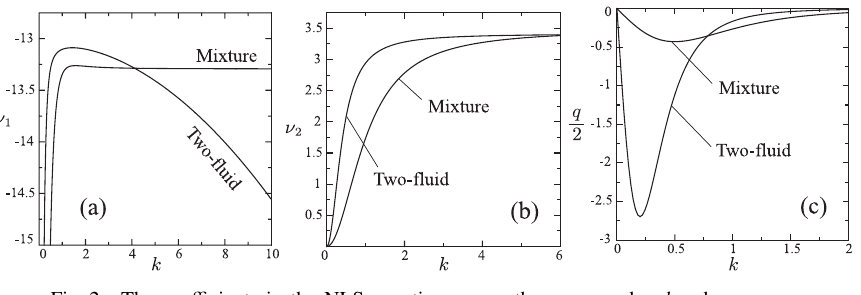
Fig. 2 The coe ffi cients in the NLS equation versus the wavenumber k , where α 0 = 0 . 05, (cid:3) = 0 . 07, and other physical quantities are the same as those used in Fig. 1. (a) Nonlinear coe ffi cient ν 1 . (b) Dissipation coe ffi cient ν 2 . (c) Dispersion coe ffi cient q / 2.